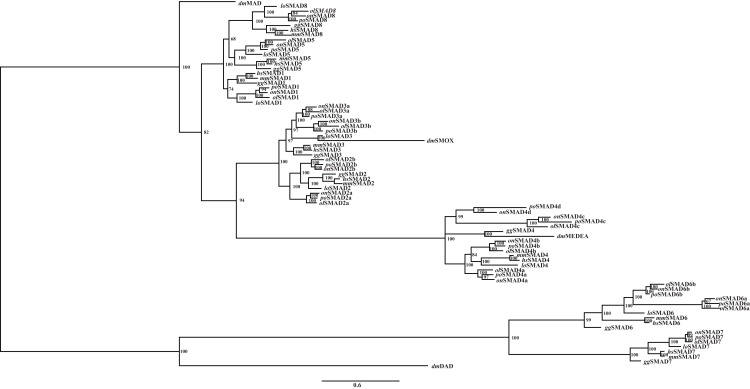
Phylogenetic analyses of SMAD gene family.Phylogenetic tree constructed by Bayesian method with GTR+I+G, MCMC = 800,000. Numbers at the tree nodes are posterior probabilities. Po, Paralichthys olivaceus; Hs, Homo sapiens; Mm, Mus musculus; Gg, Gallus gallus; On, Oreochromis niloticus; Lo, Lepisosteus oculatus; Dm, Drosophila melanogaster; Ol, Oryzias latipes.